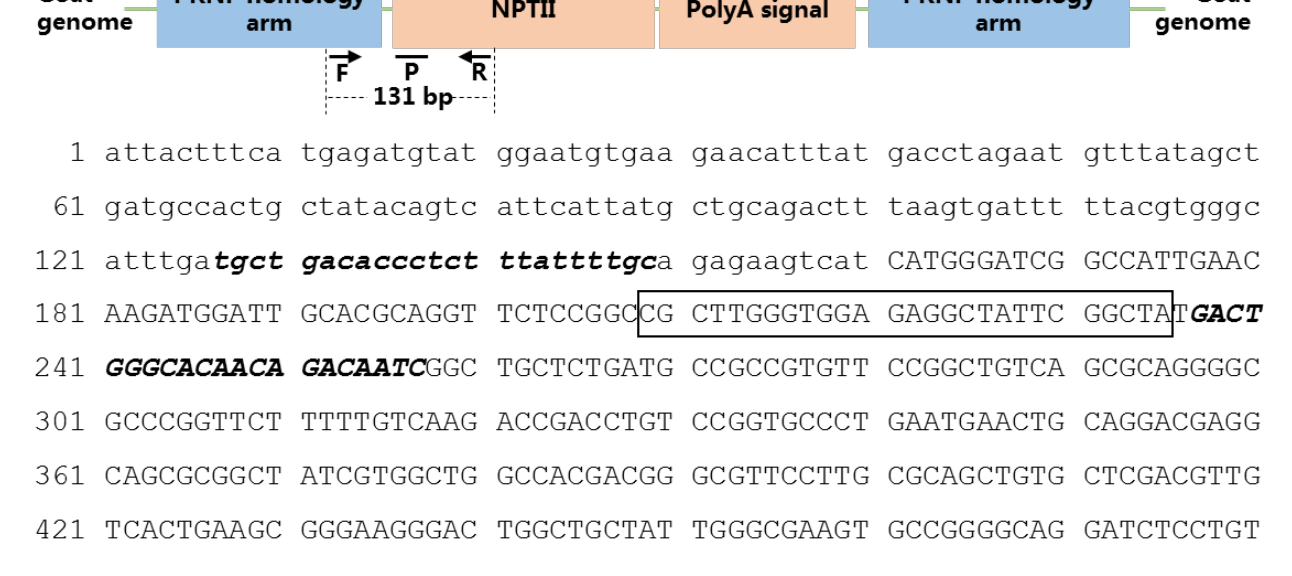
Figure 1. Schematic information and the location of the event-specific primers and probe in GM event KoP1. PRNP : prion protein gene, NPTII : neomycin-kanamycin phosphotransferase type II, F: forward primer, R: reverse primer, P: TaqMan probe. Lowercase letters represent the goat genomic DNA sequence, capital letters represent the NPTII sequence, bold italic letters represent the forward and reverse primers, letters in the frame is the TaqMan probe. Table 1. List of primers and probes for ddPCR analysis.